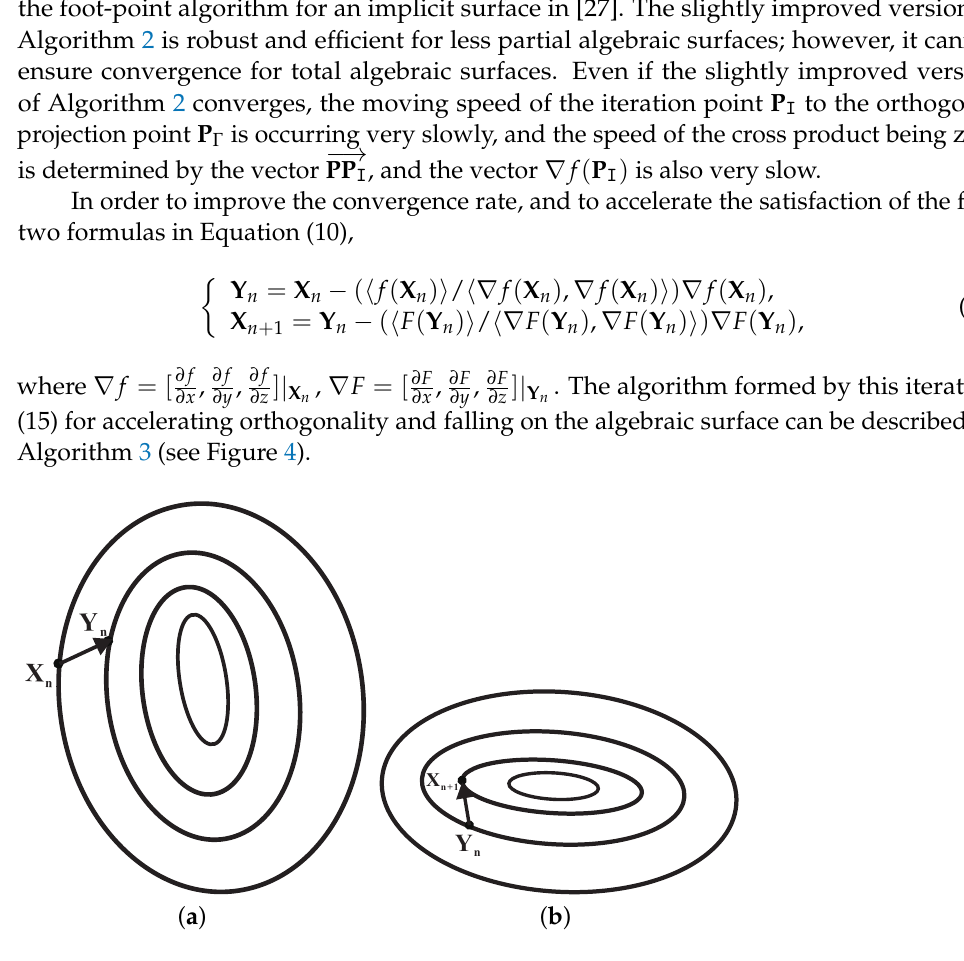
Figure 4. The whole graphic demonstration of Algorithm 3. ( a ) Newton’s gradient descent method unrelated to the test point of the first formula in Equation (15); ( b ) Newton’s gradient descent method associated with the test point of the second formula in Equation (15); All the curves of figures ( a , b ) denote contour surfaces and not contour